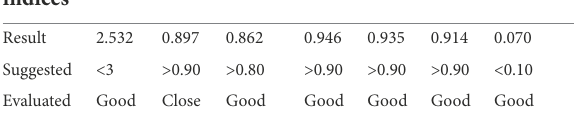
TABLE 3 Model fit indices of confirmatory factor analysis. Model